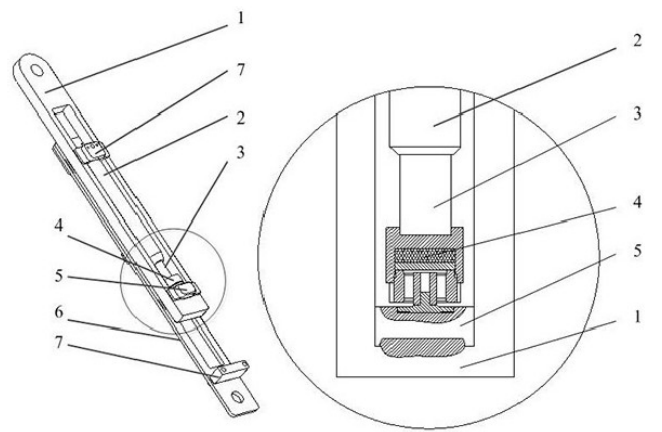
Figure 4. The hydraulic balancing cylinder model. 1—medium plate; 2—hydraulic cylinder; 3—piston rod; 4—particle damping sensor; 5—slide block; 6—side plate; 7—connecting pin.